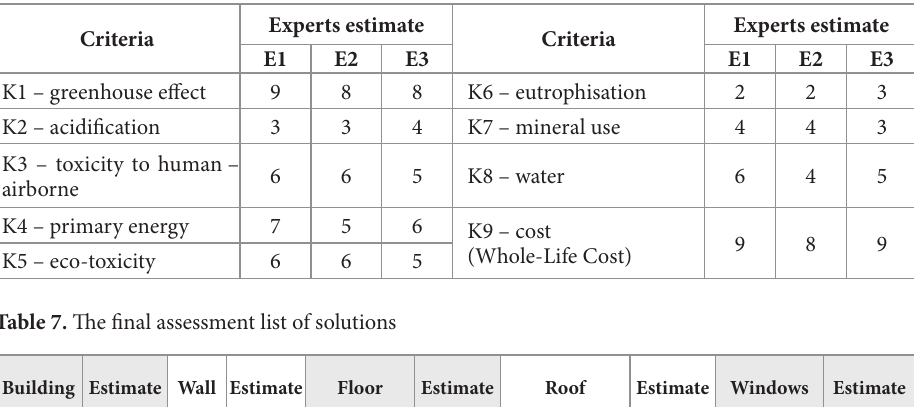
Table 6. The point estimate of criteria weighting Criteria